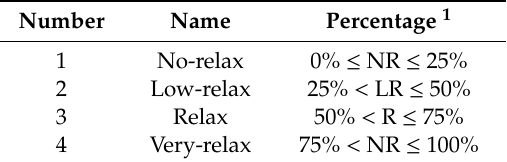
Table 2. Proposed Table 2. Proposed classification.